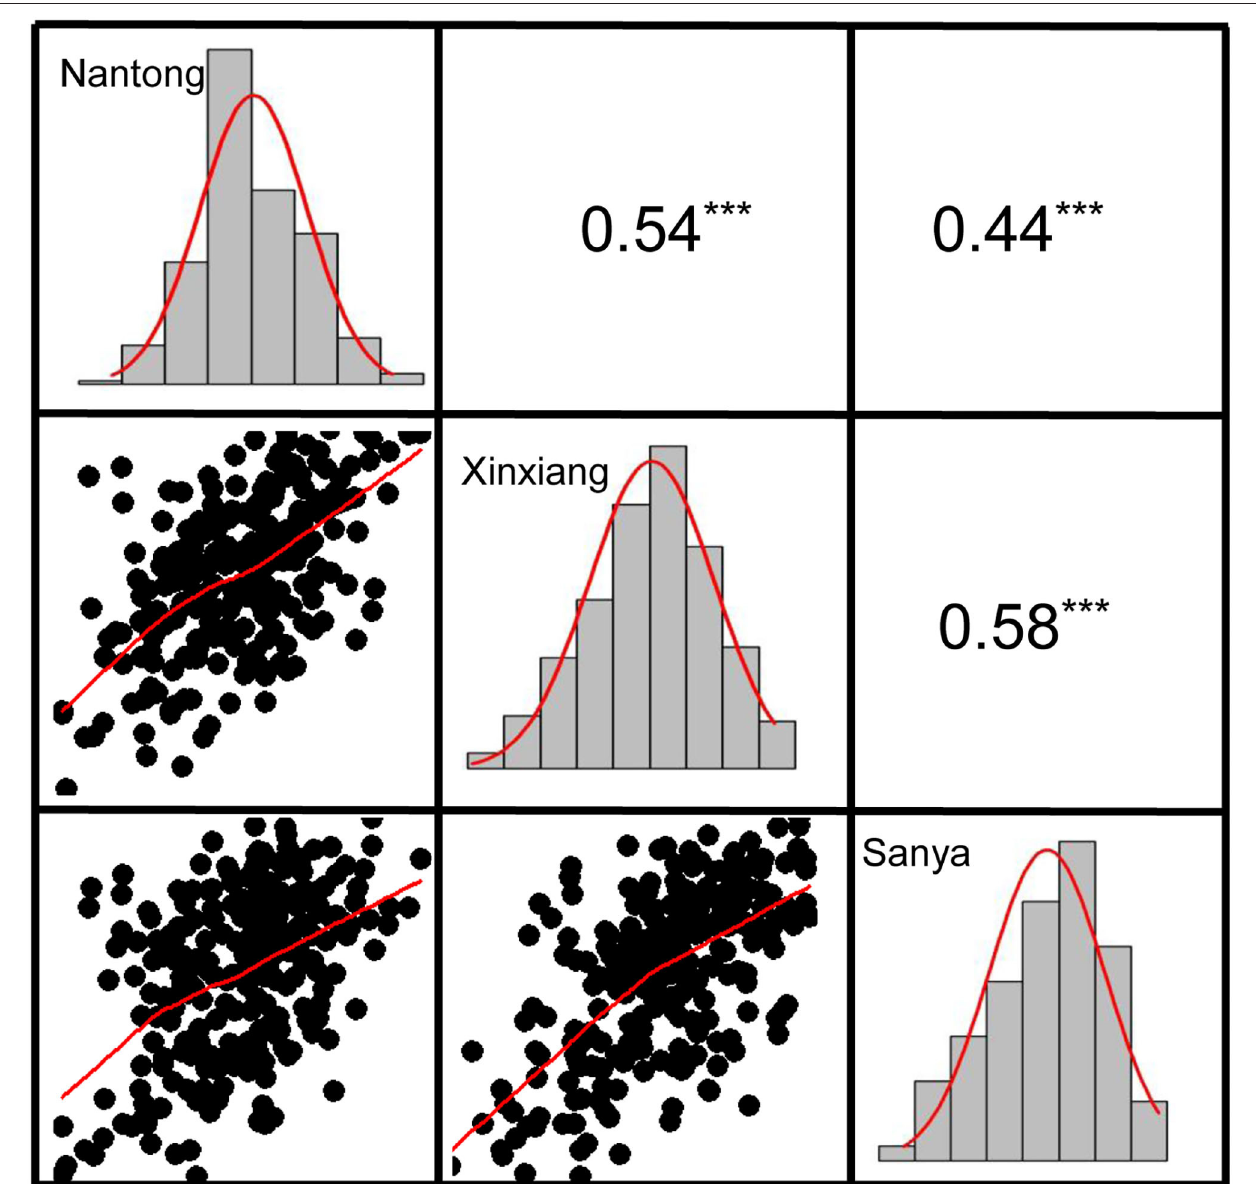
FIGURE 3 | The correlation and frequency distribution of KMC in three environments. The upper panel is correlation coefficients, and the lower panel is scatter plots. The histogram represents the frequency distribution of the trait. ***the significance level at P <